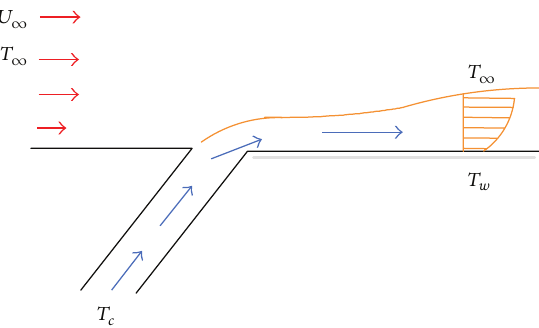
Figure 2: Protective film layer made by coolant